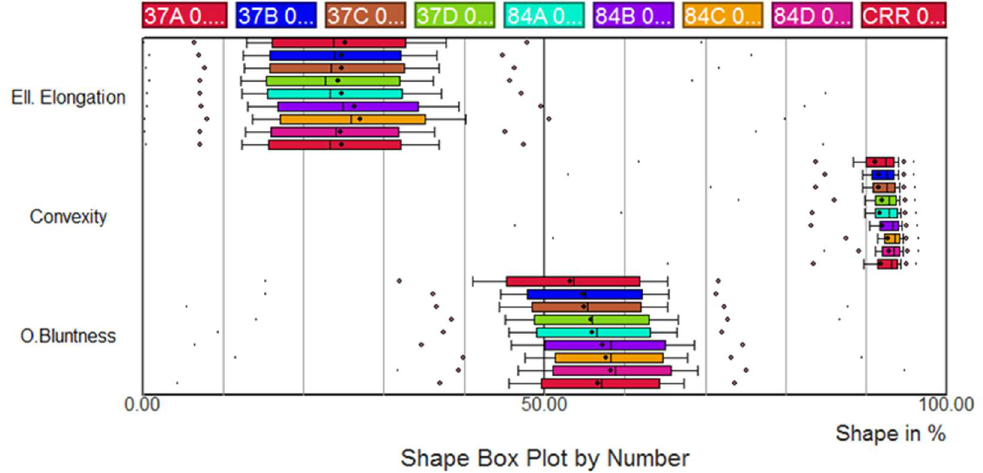
Figure 7. Shape analysis of particles (0.063–0.125 mm) (84 refers to raw materials: 84A, 84B, 84C